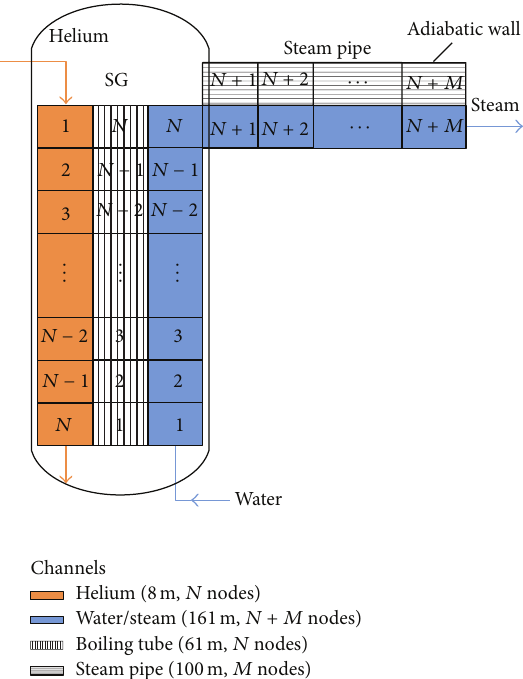
Figure 3: Nodalization of SG and